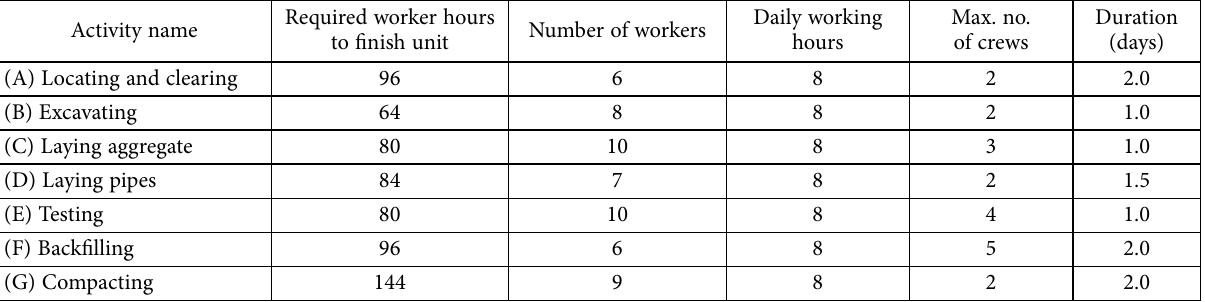
Table 1. Information about the pipeline project